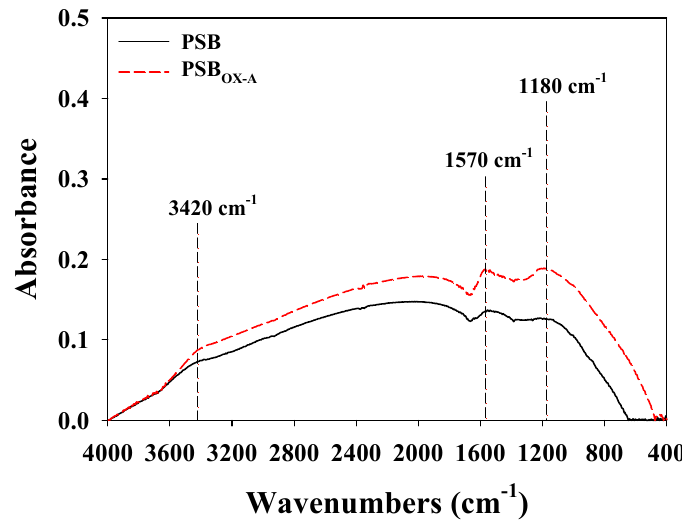
Figure 3. Fourier-transform infrared (FTIR) spectra of PSB and PSB OX-A .